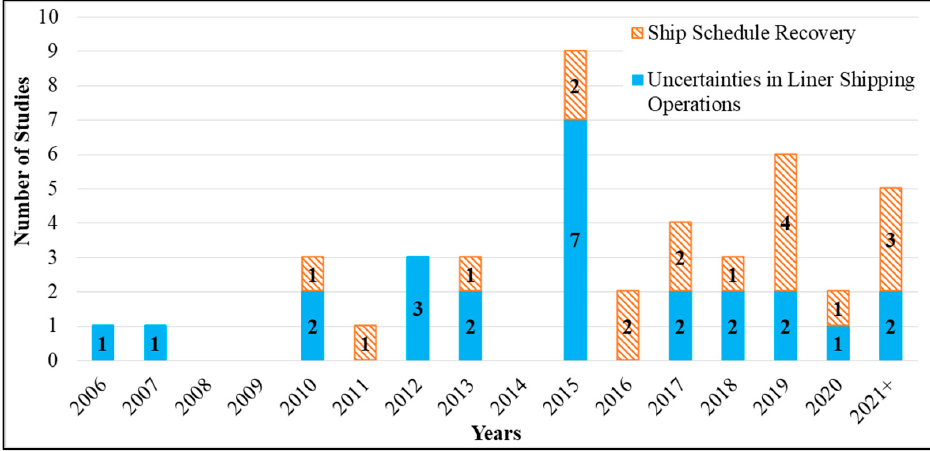
Figure 2. Distribution of the collected studies by year.